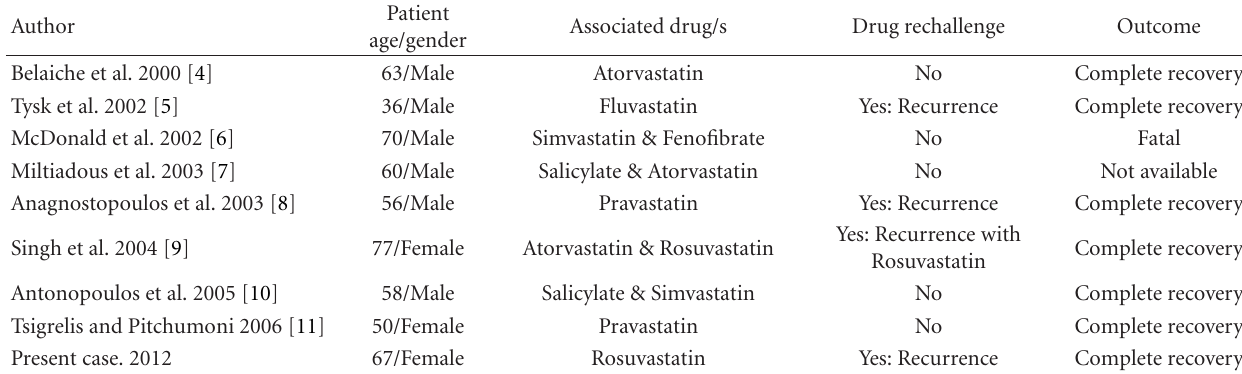
Table 2: Previously reported cases of statin-induced